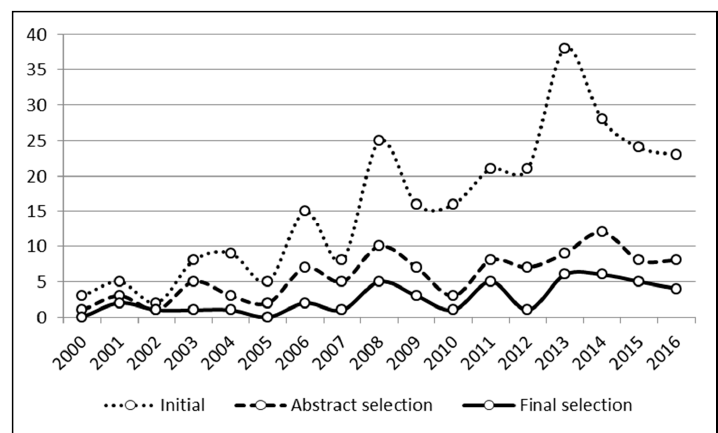
Figure 3. Number of published papers per year at different review process stages.